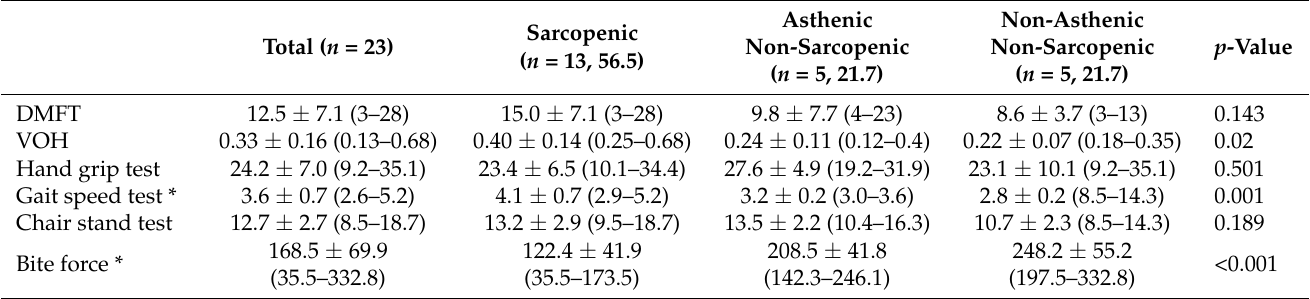
Table 2. Comparison of the measurements obtained: DMFT, Value of Hue (VOH), hand grip test, gait speed test, chair stand test and bite force measured in the three groups of patients.